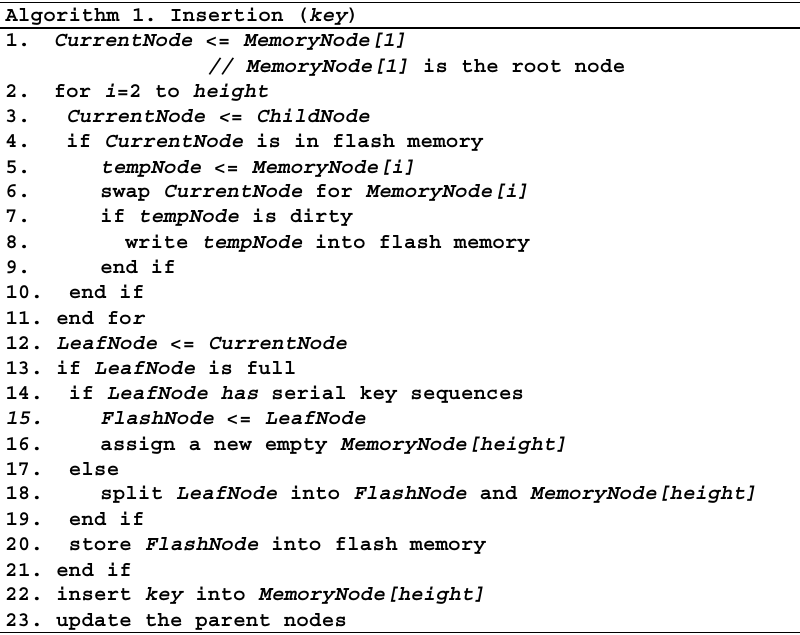
Figure 7. Pseudo code of the insert operation.